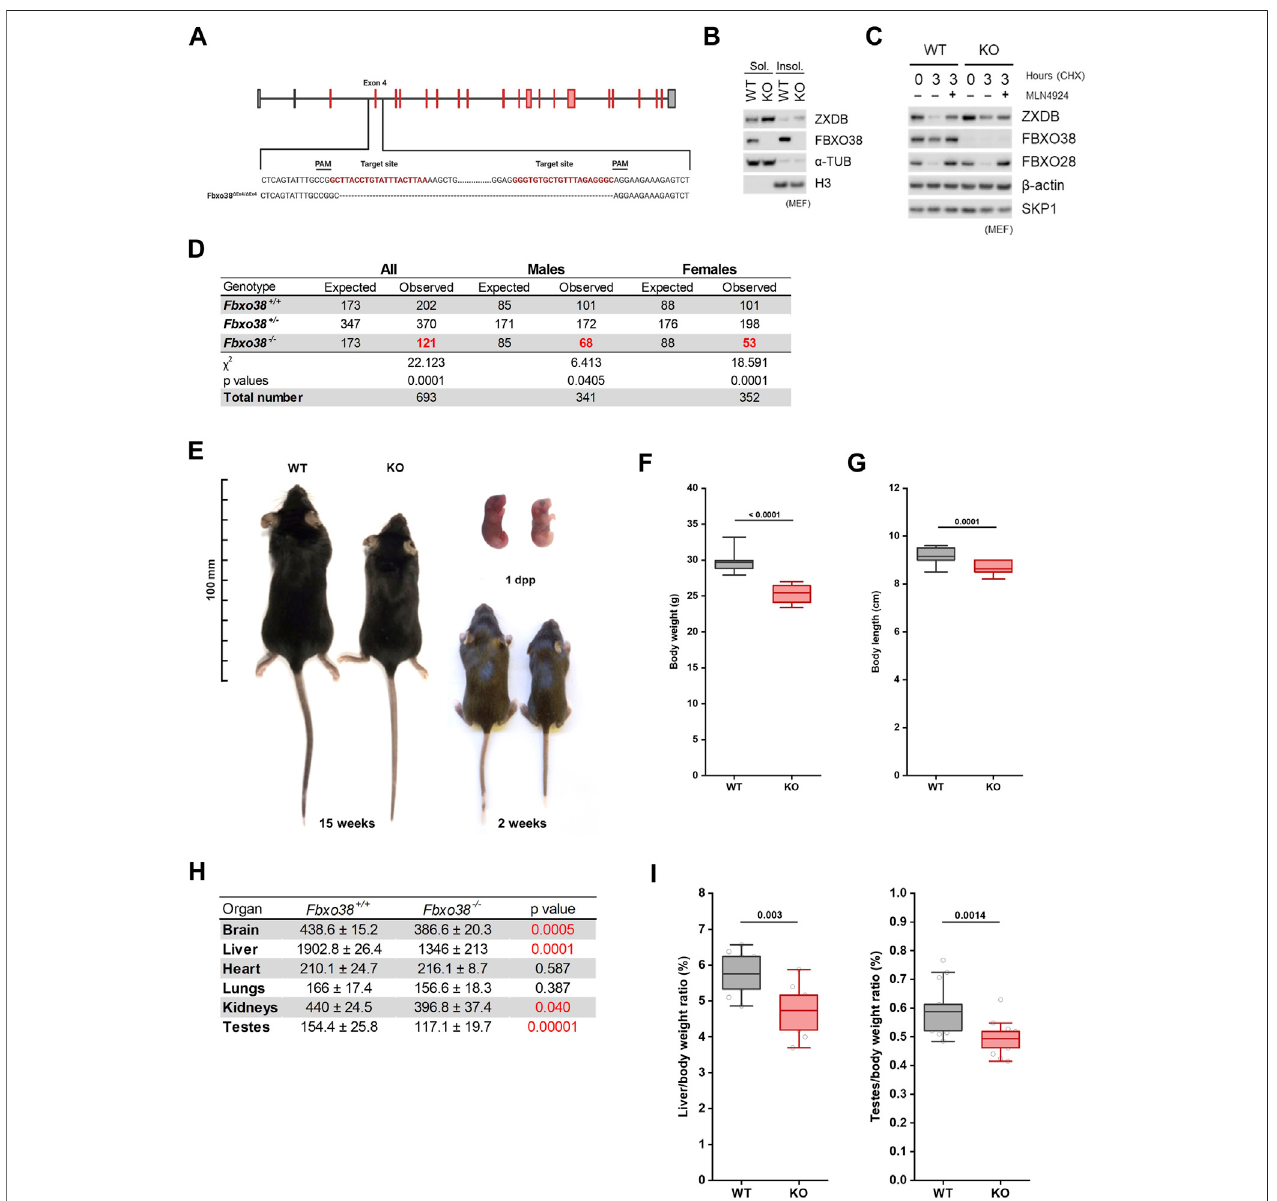
FIGURE 1 | FBXO38 de fi ciency leads to growth retardation in mouse. (A) Scheme illustrating mouse Fbxo38 gene structure and its targeted disruption using a CRISPR/Cas9 genome-editing system. Two single guide RNAs (sgRNAs) were designed to target intron sequences (sequence in red) fl anking exon four of the Fbxo38 gene. Translated exons are depicted in red color. PAM; protospacer adjacent motif, dashed line indicates deleted nucleotides in Fbxo38 Δ Ex4/ Δ Ex4 animals. (B) SV40 immortalized MEF generated from Fbxo38 wild-type (WT) and knockout (KO) E13.5 embryos were subjected to lysis. Soluble and insoluble fractions were immunoblotted as indicated; ɑ -tubulin and histone H3 were used as loading and fractionation controls. (C) MEF (as in C) were treated with cycloheximide (CHX) for 3 h and pre-treated with MLN4924 for 1 h where indicated. Whole-cell lysates were immunoblotted as indicated. Staining of FBXO28 was used as a control for CUL1- dependent degradation. (D) Observed and expected mouse genotypes ofweaned pups from heterozygous breedings. The proportion of mice with different genotypes was compared to expected Mendelian ratios by the Chi-square test. Signi fi cant deviations from the expected numbers are shown in red. (E) Representative images of Fbxo38WTandKOlittermatemalesofindicatedage.Dpp;dayspostpartum. (F) Bodyweightofadult(17 – 21 weeks) Fbxo38 WTandKOmales.Agedistributioninboth groups was the same ( n = 15). Statistical signi fi cance was assessed by an unpaired two-tailed t -test. (G) Body length of animals as in (E). (H) Means ± standard deviations and p-values of organ weights of Fbxo38 WT and KO males as in (E) are summarized in the table. Statistical signi fi cance was assessed by an unpaired two- tailed t -test. Statistically signi fi cantp-values arehighlighted inred (p-value < 0.05). (I) Liver(left)and testes (right)weight tobodyweight ratio ofadult Fbxo38 WTand KO males(liver: n =9;testes: n =14).Individualdatapointsareshown.Horizontalbarsshowmeanvalues,boxesrepresent25thand75thpercentiles.Statisticalsigni fi cance was assessed by an unpaired two-tailed t -test.